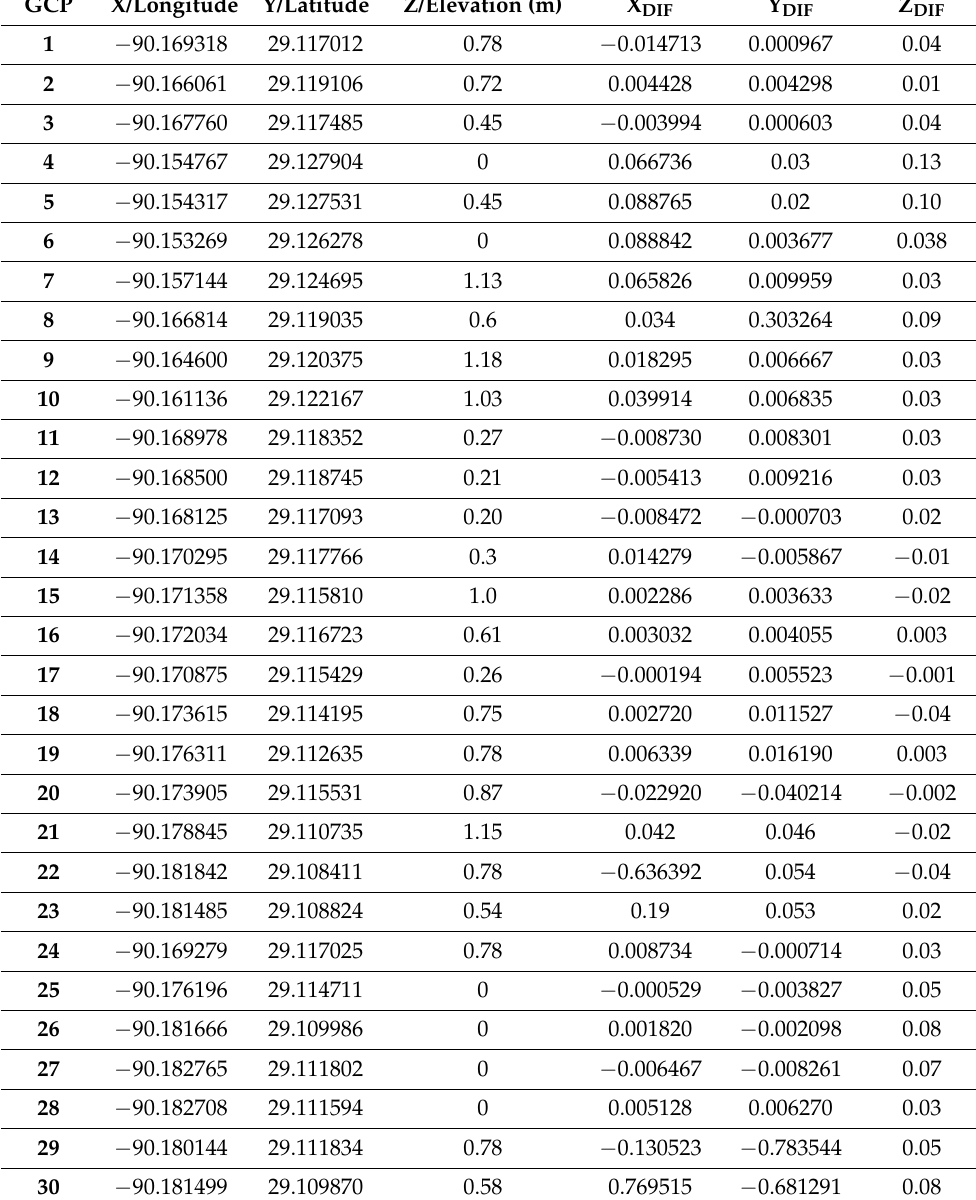
Table 1. Ground Control Points of the study area with longitude, latitude, elevation, and differences (m) between latitudes, longitudes, and elevation obtained by photogrammetry and those obtained in the field by a topographic